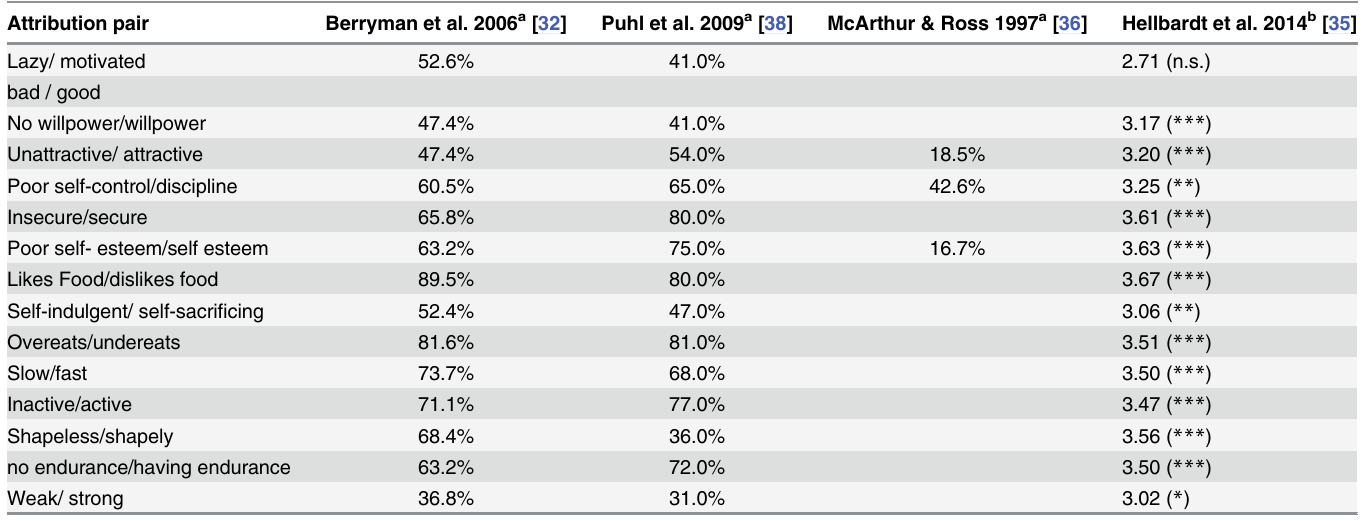
Table 3. Systematic outline of studies summarizing characteristics attributed to individuals with